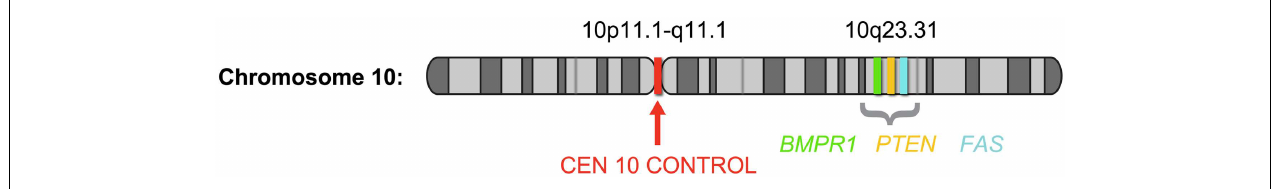
FAS (aqua) probes flanking either side of the 2.06-Mb minimal deleted region, a PTEN probe (orange) at 10q23.3 and a chromosome 10 centromere (red) copy control